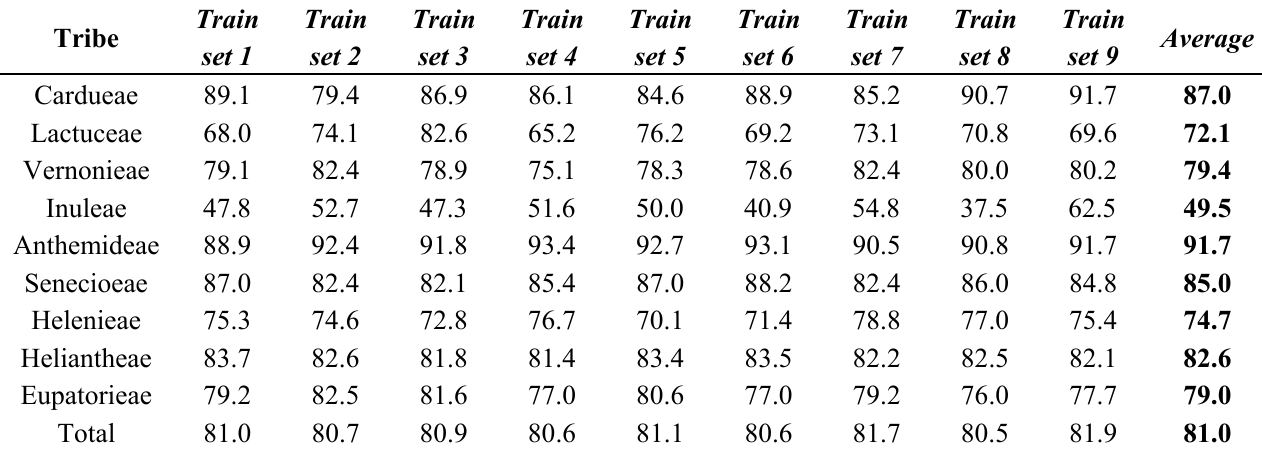
Table 4. Summary of training and test match results (%) using atom-centred descriptors.